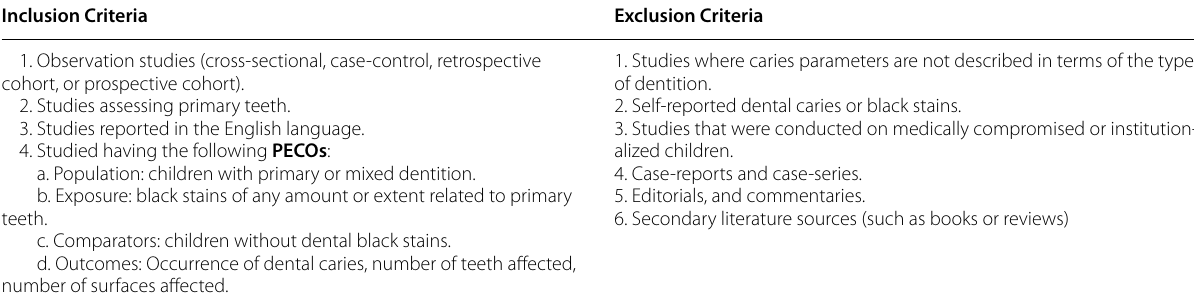
Table 1 Inclusion and exclusion criteria of the